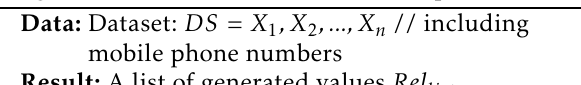
Algorithm 1: Data-Centric Relationship